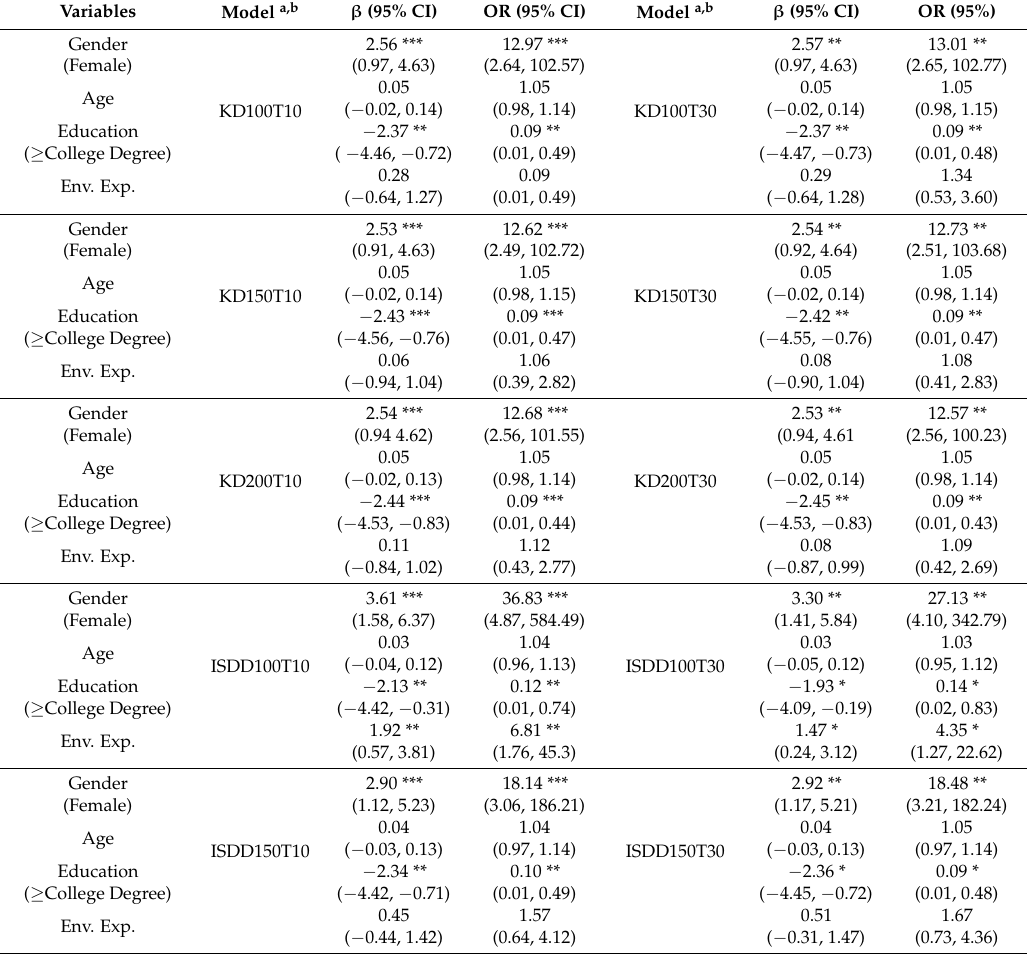
Table A3. The association between food environment exposure and overweight status analyzed by binary logistic regression models with food environment exposure measured by different